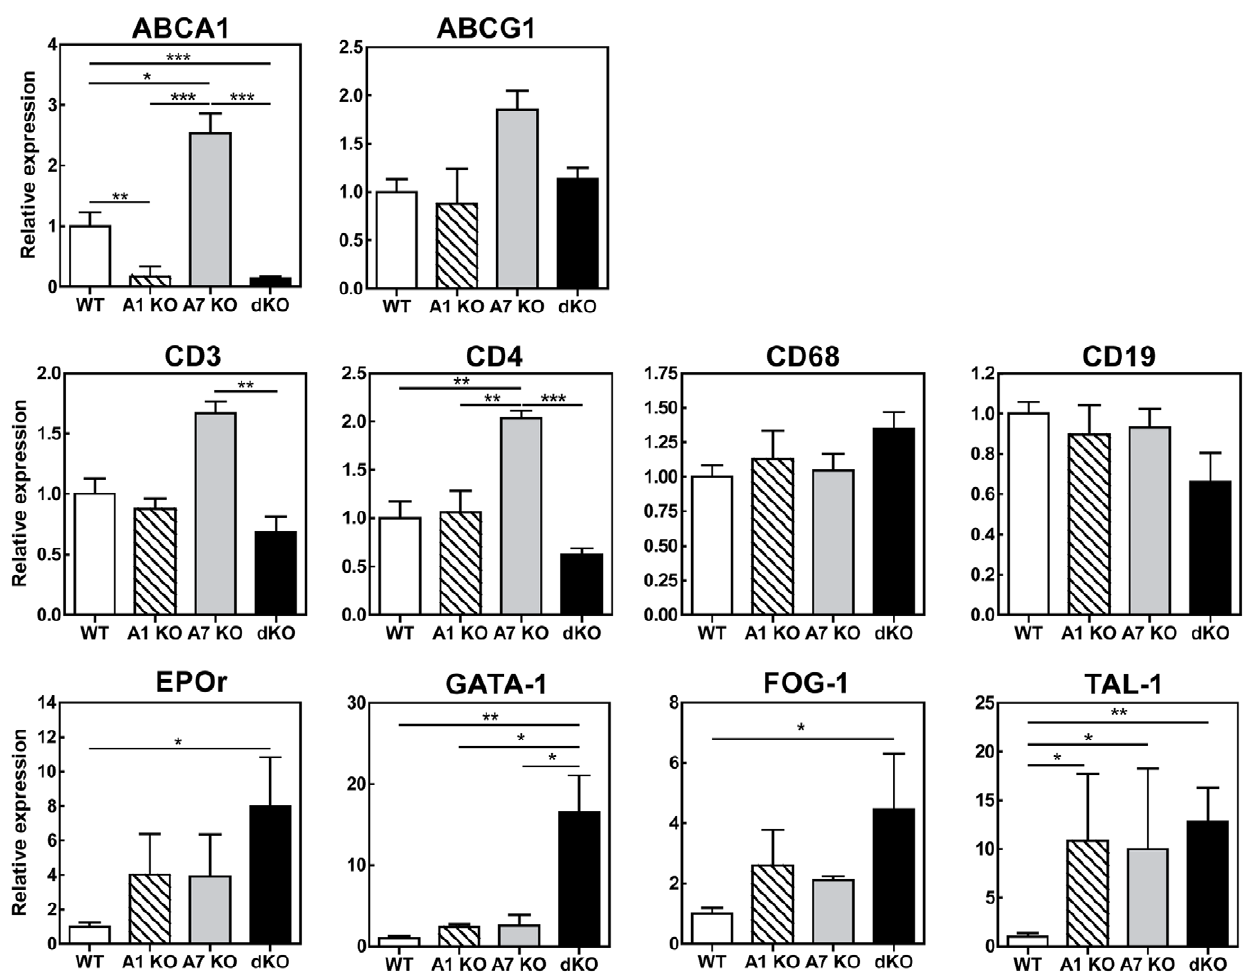
Figure 7. mRNA expression levels of genes of interest in spleens from LDLr KO mice reconstituted with WT, ABCA1 KO, ABCA7 KO and dKO bone marrow. Guanidium thiocyanate-phenol was used to extract total RNA from organs and mRNA expression was determined by real- time RT-PCR. Hypoxanthine Guanine Phosphoribosyl Transferase (HPRT), b -actin, and acidic ribosomal phosphoprotein PO (36B4) were used as the standard housekeeping genes. Relative gene expression was calculated by subtracting the threshold cycle number (Ct) of the target gene from the average Ct of housekeeping genes and raising two to the power of this difference. WT samples were all calibrated to an arbitrary unit. Values represent the mean 6 SEM of 4–6 mice per group. Statistically significant difference *p , 0.05, **p , 0.01 and ***p , 0.001.